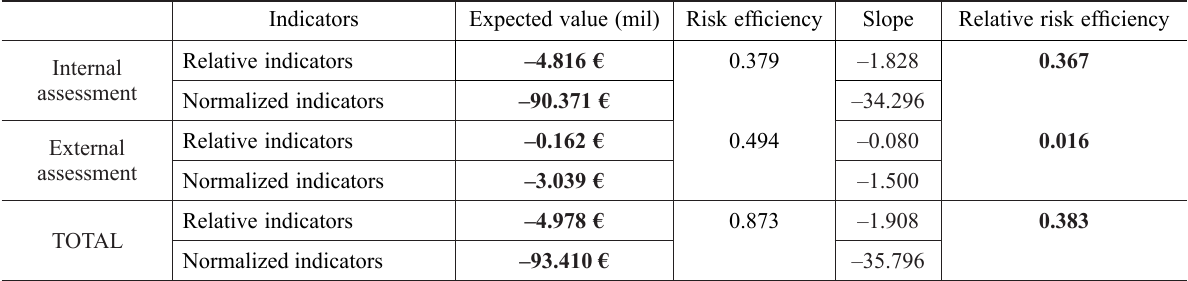
Table 1. Results of risk based internal and external